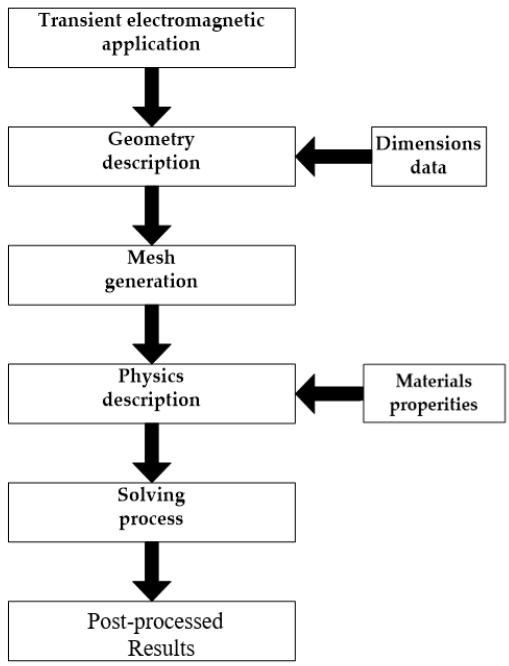
Figure 4. Transient electromagnetic application flowchart.